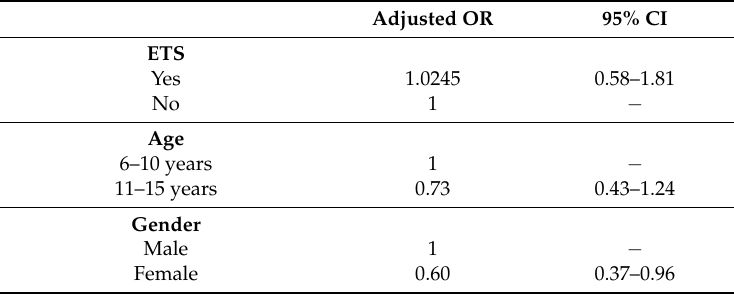
Table 6. Factors associated with Children’s Behavioral Problems (BPI ≥ 14) among Children in Multivariate Analyses ( n = 1373) †